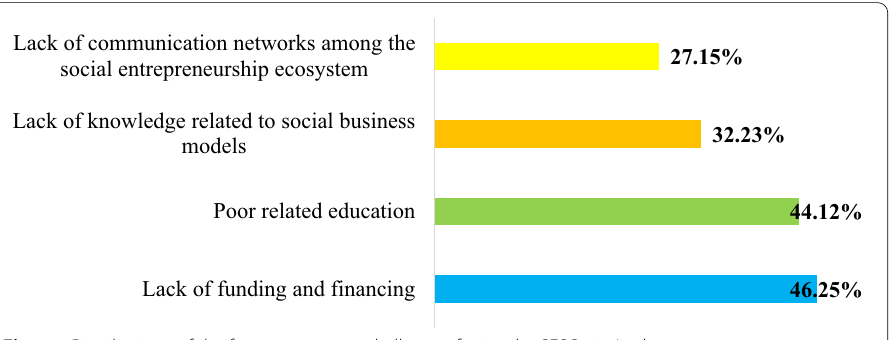
Fig. 14 Distributions of the four most severe challenges facing the SESOs in Jordan